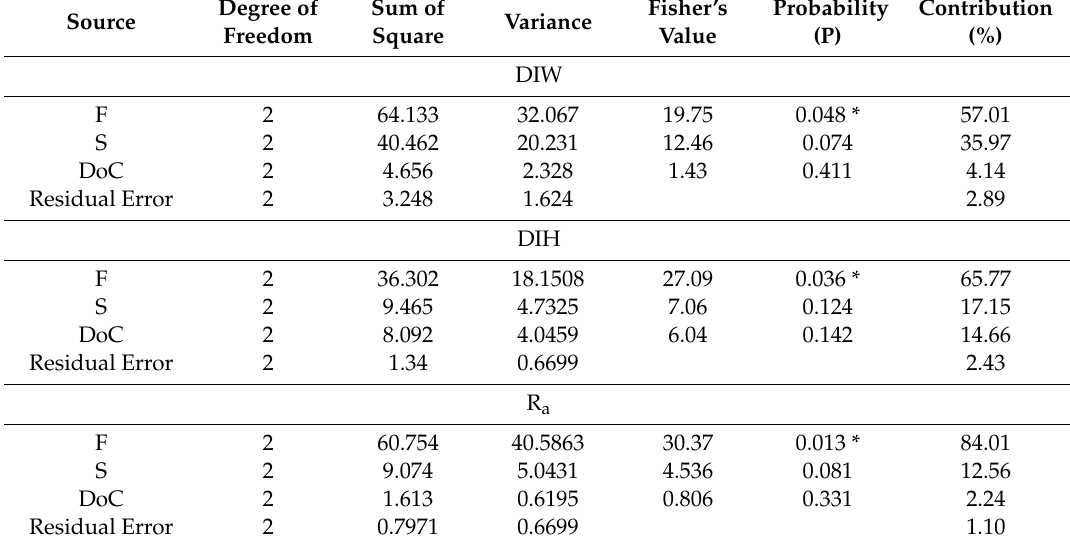
Table 5. ANOVA results for DIW, DIH, and R a .